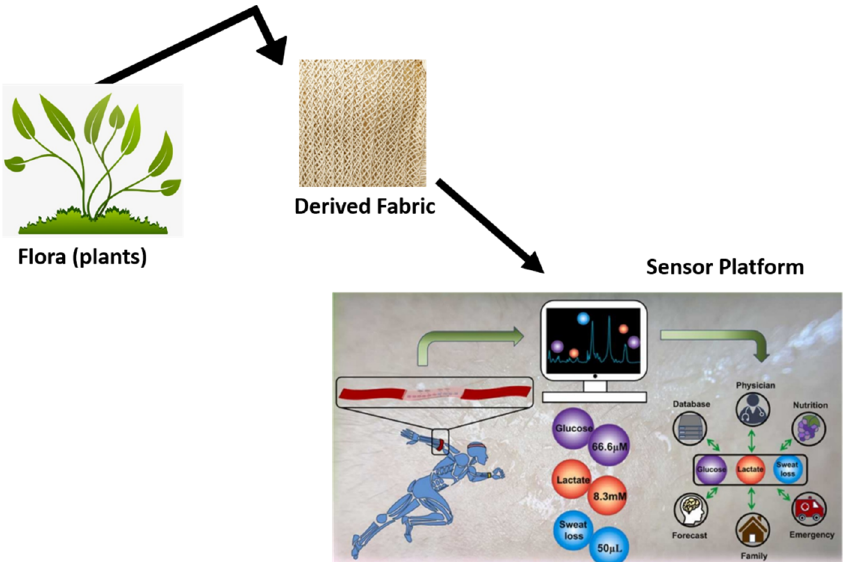
Figure 1. Illustrative image portraying the various scopes that can be explored regarding phyto- chemical and/or sensor platforms. Rights and permission, copyright [13]. ical and/or sensor platforms. Rights and permission, copyright